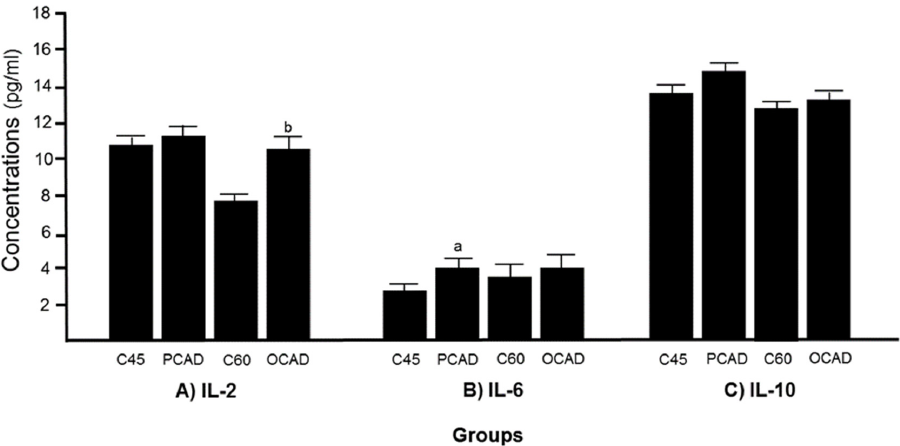
Figure 3. The concentration levels of A) IL-2, B) IL-6, and C) IL-10 in cases and control subjects. a p = 0.016 compared to C45; b p = 0.012 compared to C60. IL-2, IL-6, and IL-10 were analyzed using a t test.